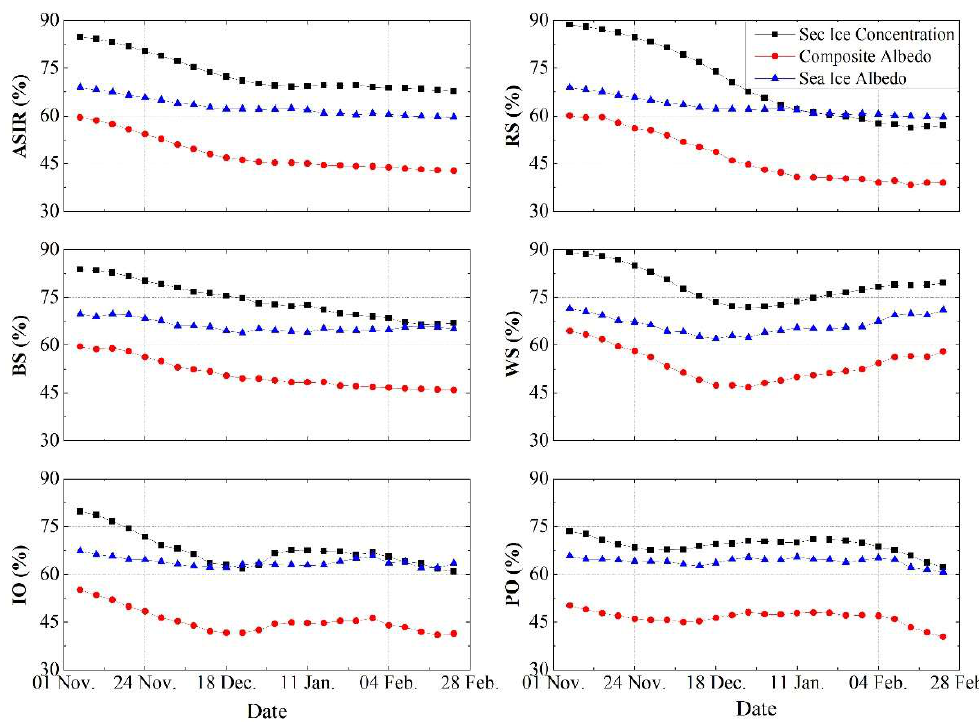
Figure 6. Seasonal evolutions of SIC (%), composite albedo (%) and sea ice albedo (%) within the ASIR and five longitudinal sectors from 1 November to 28 February averaged over 1982–2015. Table 6. Correlation coefficients between composite albedo and SIC or sea ice albedo for ASIR and five longitudinal sectors. ASIR